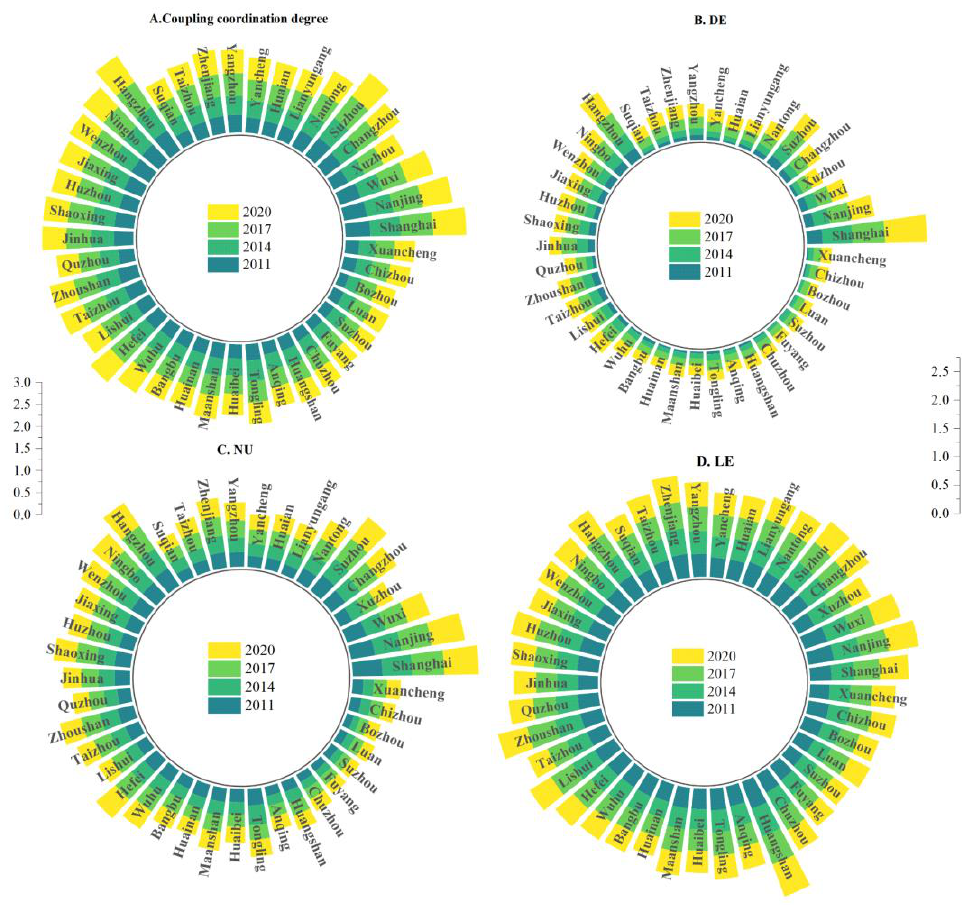
Figure 3. The changes of DE – NU – LE and the coupling coordination degree of each prefecture-level city in the Yangtze River Delta over different years.(Subfigure A presents the change of the coupling level city in the Yangtze River Delta over different years. (( A ) presents the change of the coupling coordination degree. Subfigure B presents the change of DE. Subfigure C presents the change of NU. coordination degree. ( B ) presents the change of DE. ( C ) presents the change of NU. ( D ) presents the Subfigure D presents the change of LE.) change of